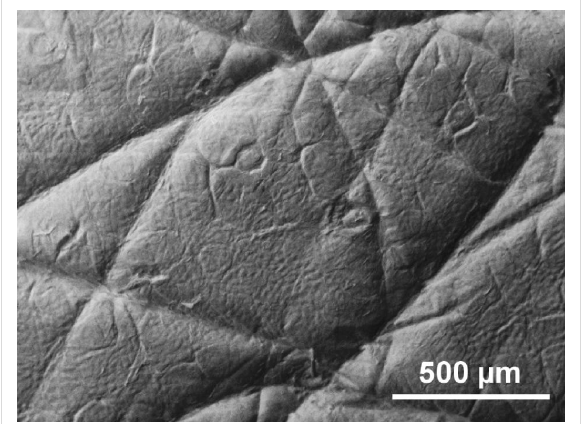
Figure 1: Scanning electron microscopy picture of a mould of wet human wrist skin.